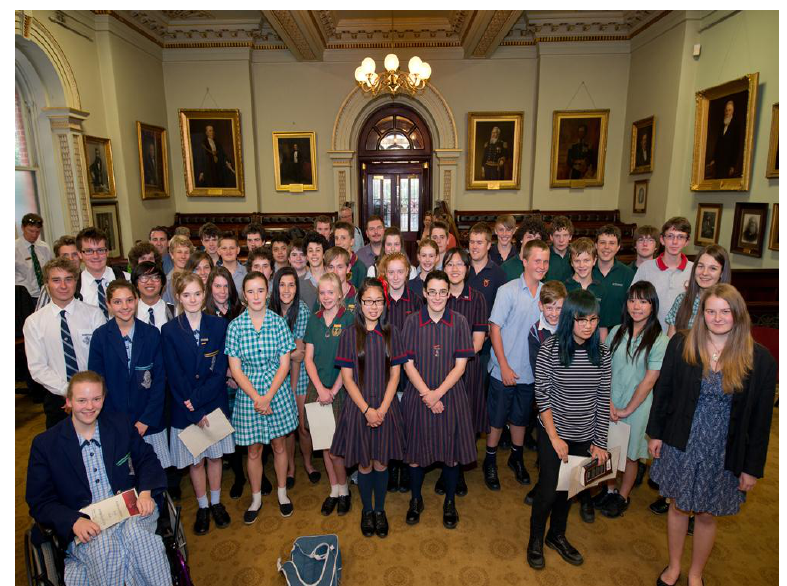
Figure 3. Adelaide Ecopolicyade in the town hall